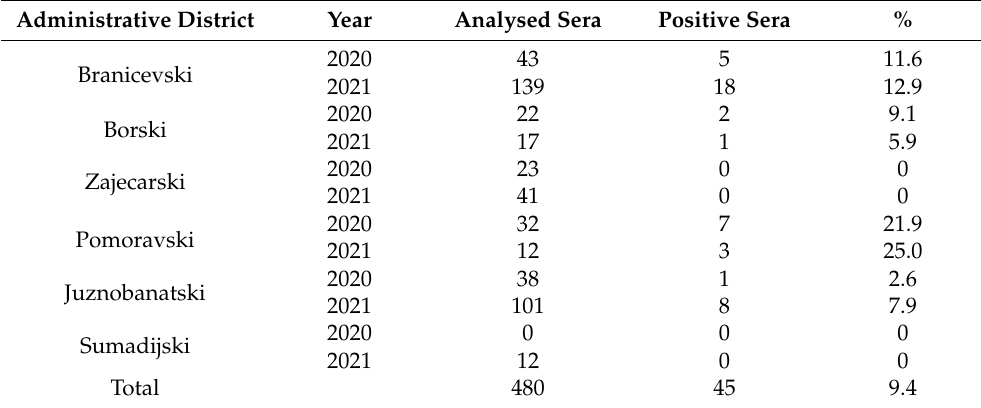
Table 1. Seroprevalence of Brucella in wild boars in